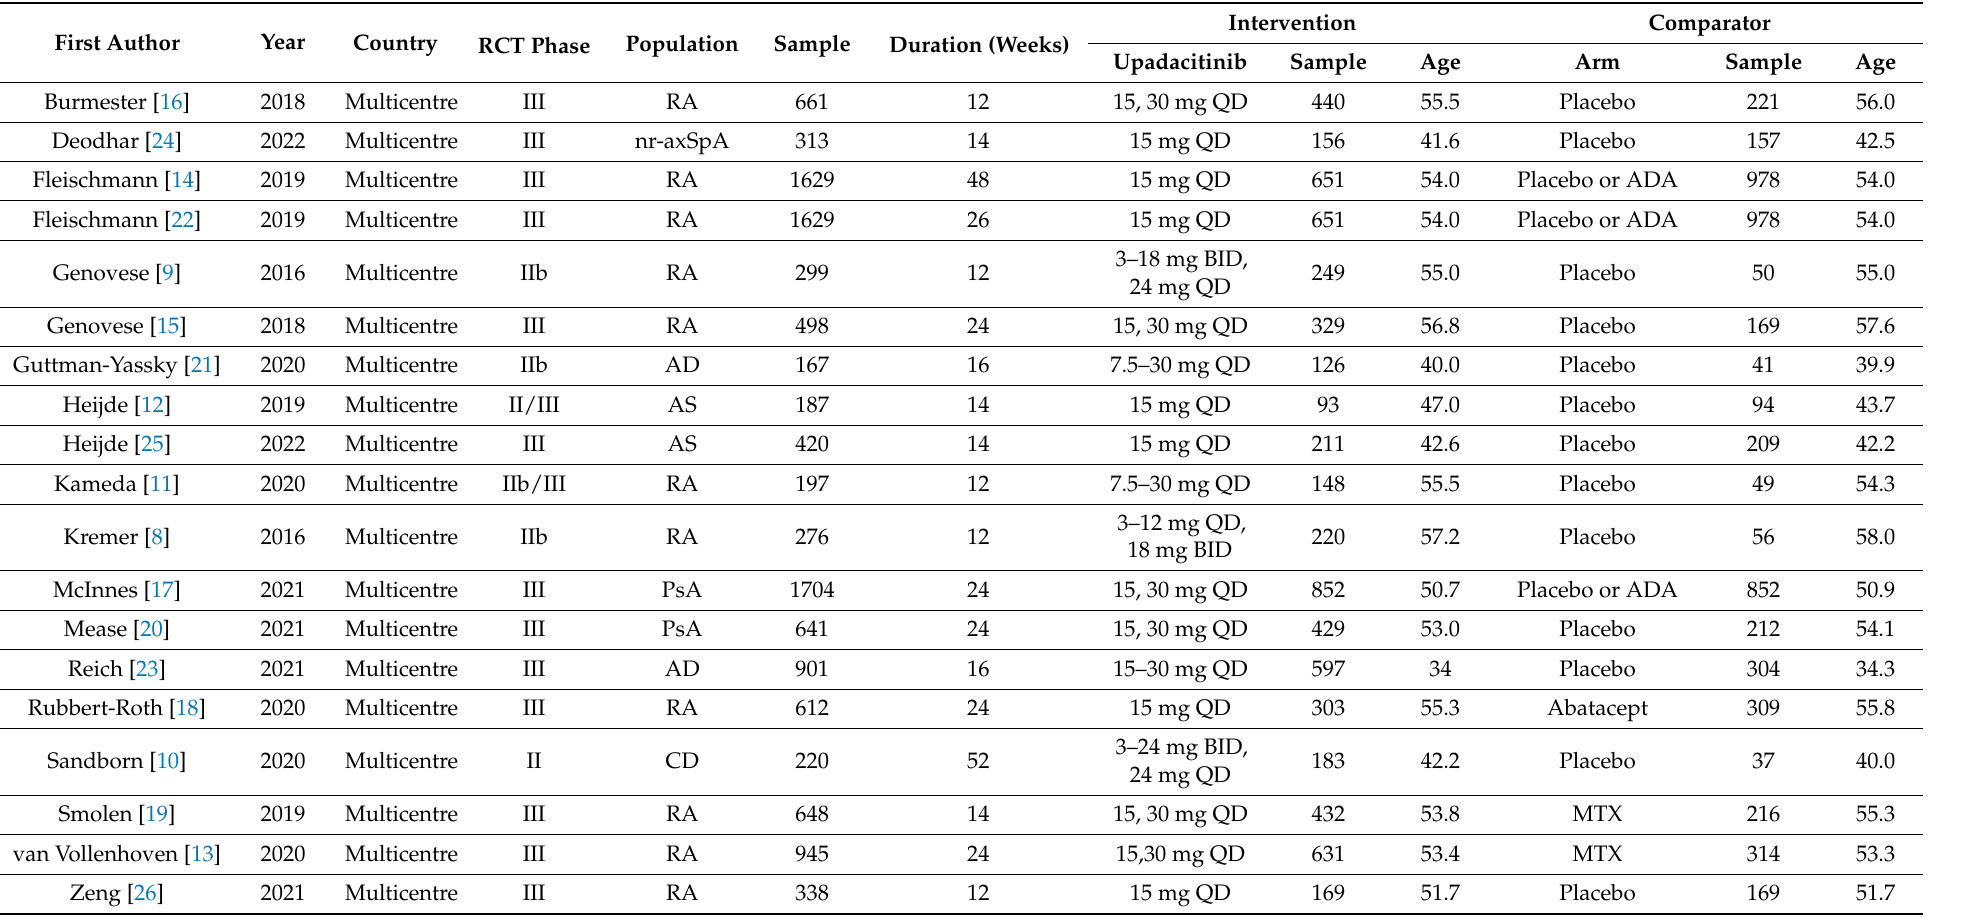
Table 1. Characteristics of the eligible